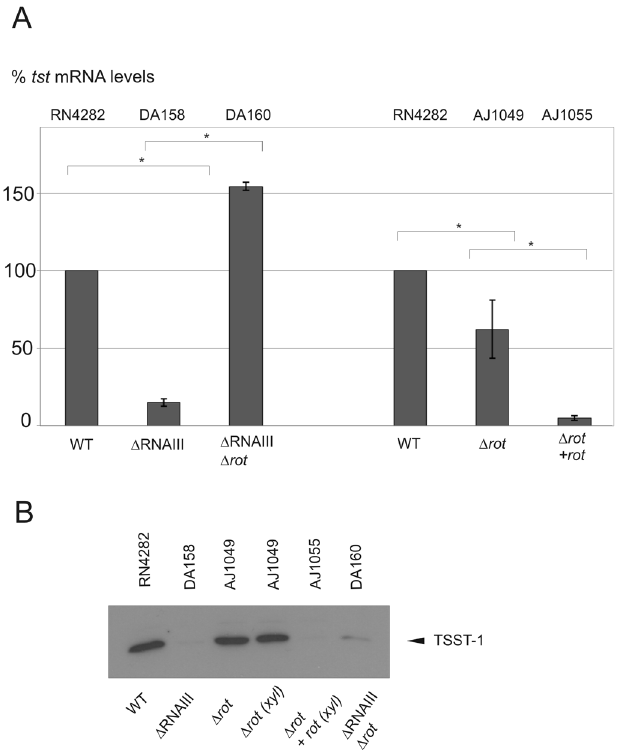
Fig 3. The effect of RNAIII and rot disruption or overexpression on tst and TSST-1 in RN4282. A. Quantitative qRT-PCR measurements of tst expression and setting RN4282 as 100%. Bars show +/- standard deviations. All data were compiled from three independent experiments. Statistical significance was evaluated by Student ’ s paired t test, and data were considered significant when P was < 0.05. B. Western blot of TSST-1, using anti-TSST-1 polyclonal antibody after precipitation from supernatants of the indicated strains. In lane 4 and 5 both samples include xylose to discard effect of the latter on tst expression. The experiment shown is representative of several independent